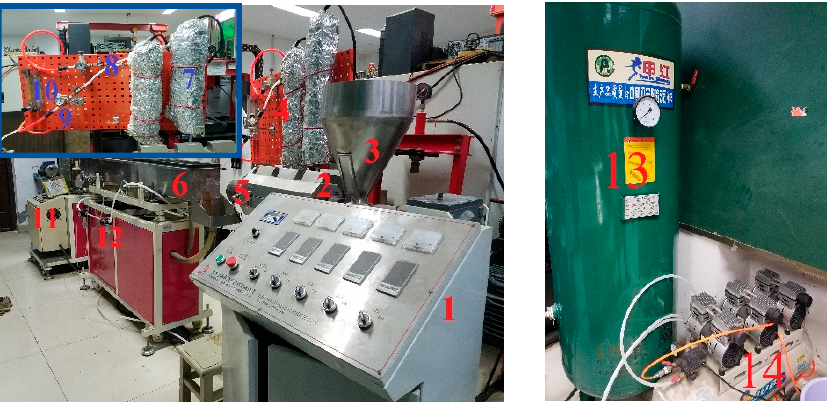
Figure 1. Experimental machine. 1 —Extruder console; 2 —Single-screw extruder; 3 —Extruder feed shake; 4 —Gas unit console; 5 —Die; 6—Cooling sink; 7 —Gas heating device; 8 —Gas pipeline; 9 —Pressure controller; 10 —Rotameter; 11 —pulling system; 12 —pressure regulating filter; 13 —Gas